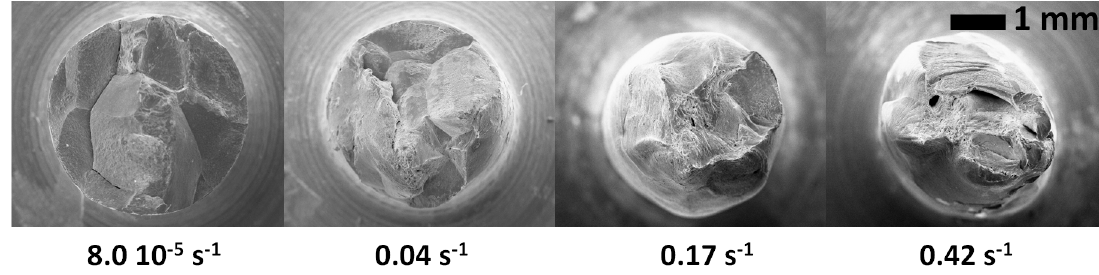
Figure 6. The fracture surfaces of the 9 ppm S specimens, tensile tested at 850 ◦ C at di ff erent strain Figure 6: The fracture surfaces of the 9 ppm S specimens, tensile tested at 850 °C at different strain rates.